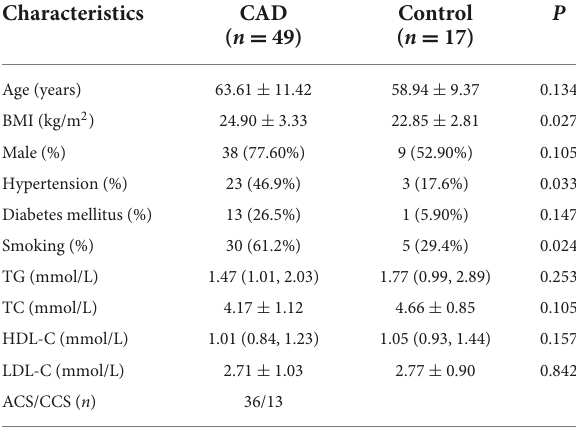
TABLE 1 Clinical baseline characteristics of study